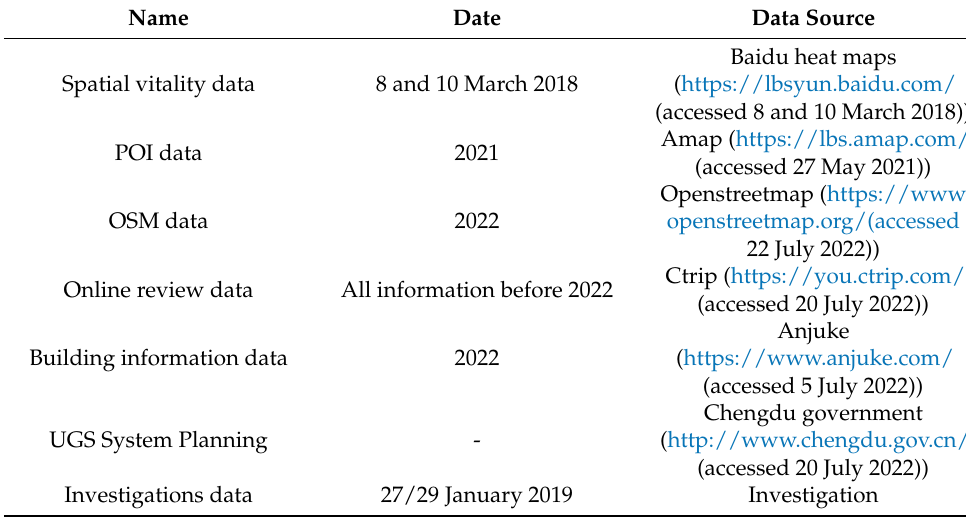
Table 1. Data name, date and